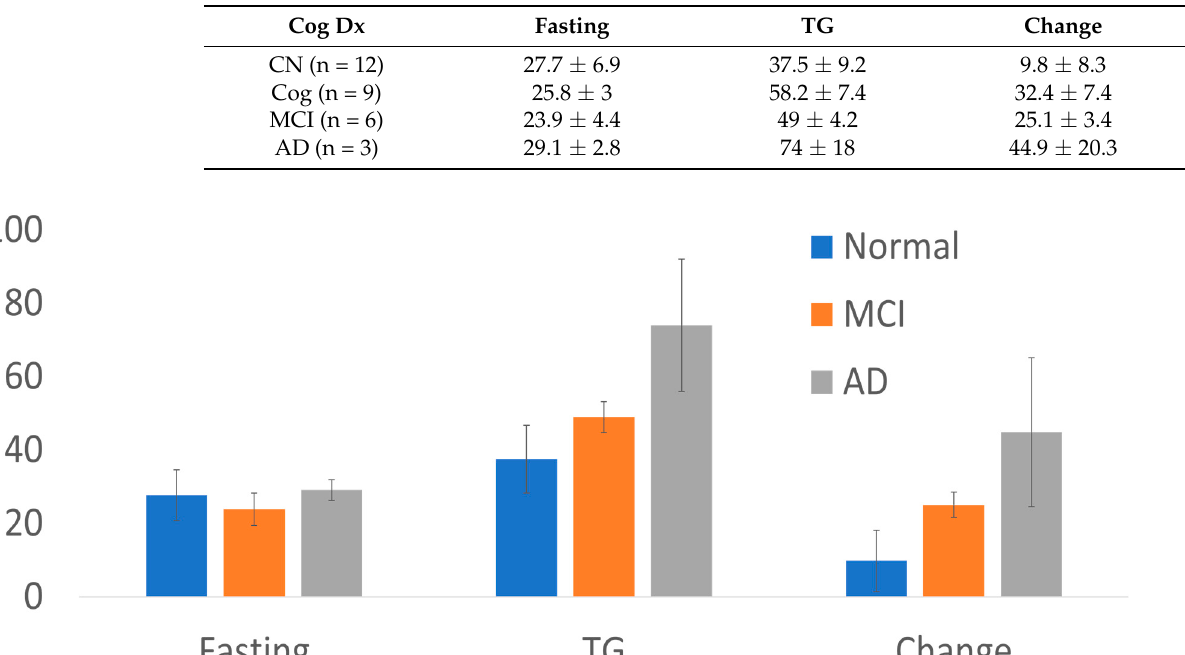
Table 4. HBA levels (uM) by cognitive diagnosis (adjusted for age) given are mean +/ − standard error.